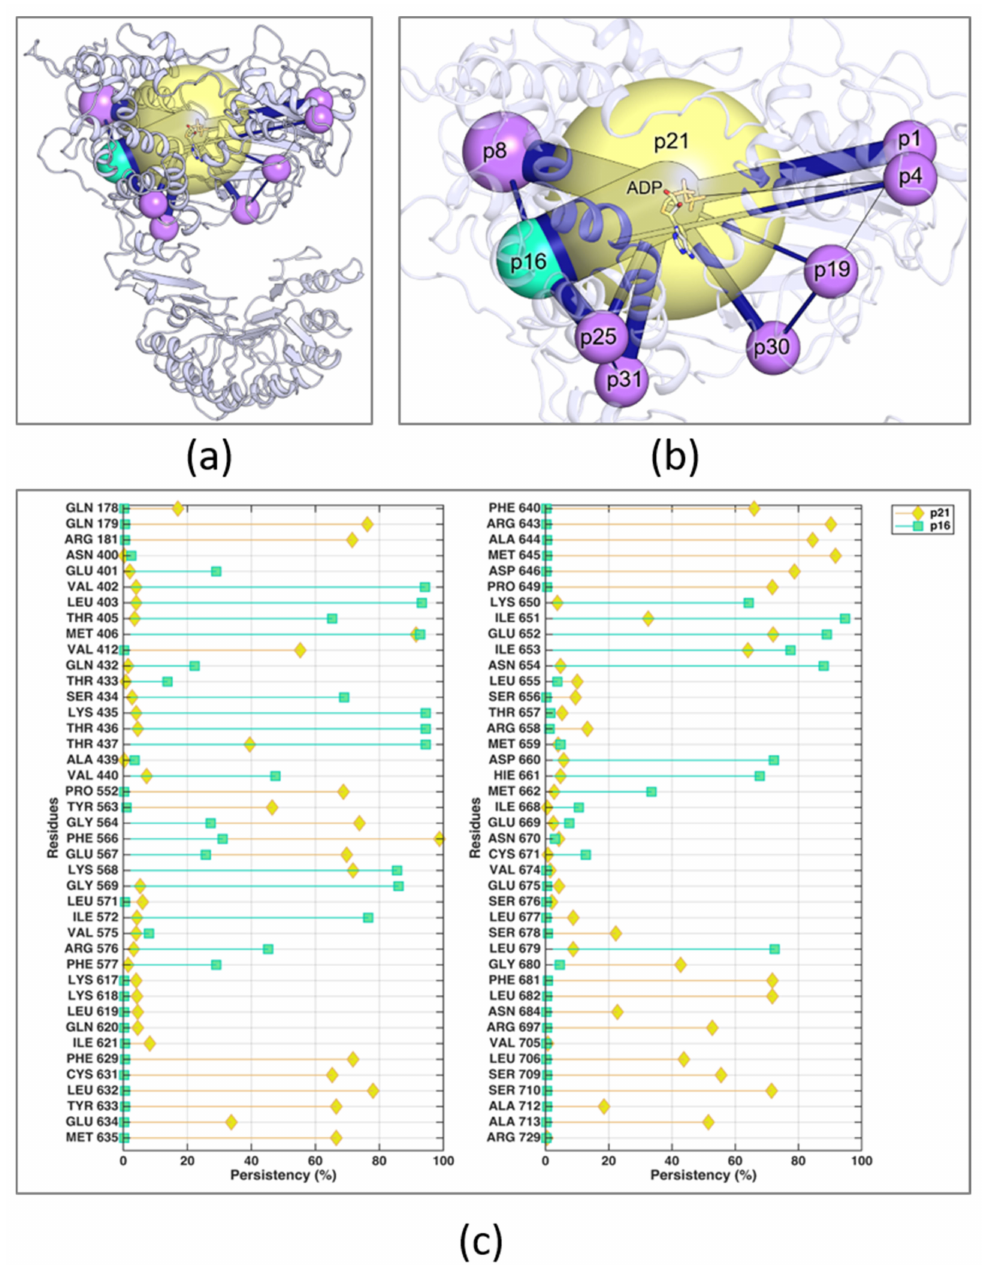
Figure 7. ( a ) Dynamic pocket network. Pockets with 90% or higher persistency are represented as spheres, with the sphere radius being proportional to pocket volume. Each pocket represents a node in the network, and dark blue edges represent the cross talk between pockets, with their thickness being proportional to the degree of correlation. Protein and ADP molecules are reported as cartoons and sticks, respectively. ( b ) Close-up of the NACHT domain. Pockets with 90% or higher persistency are labelled according to their pocket ID. ADP pocket (p21) is highlighted in yellow, p16 pocket is coloured in bright green. ( c ) Communication between the ADP pocket and p16. Persistency (% of frames) of residues belonging to the ADP pocket (p21, yellow circles) compared to those belonging to p16 (green